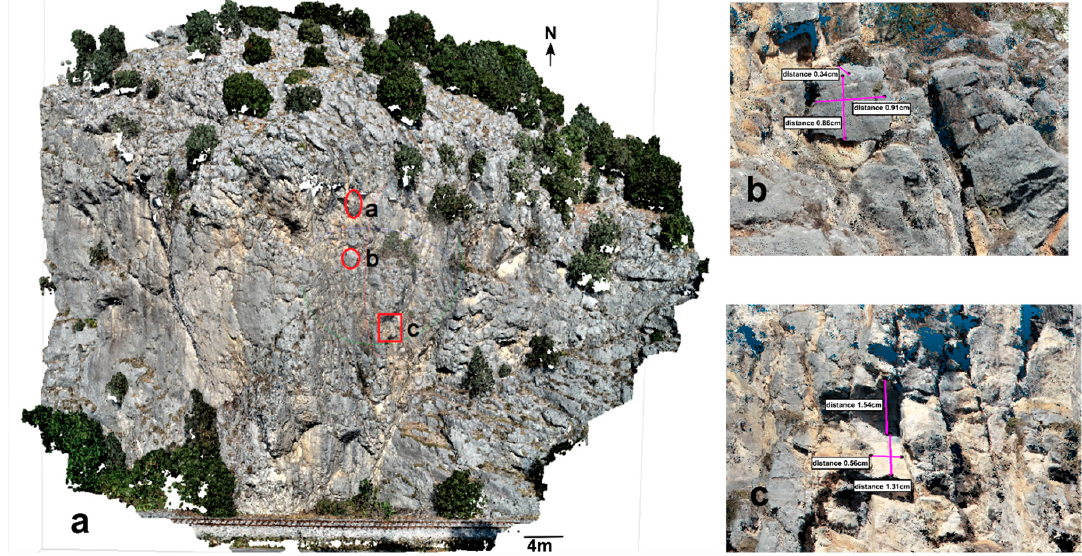
Figure 10. ( a ) Delineation of likely to failure blocks, ( b ) size characteristics of the block b, ( c ) size characteristics of the source area c.